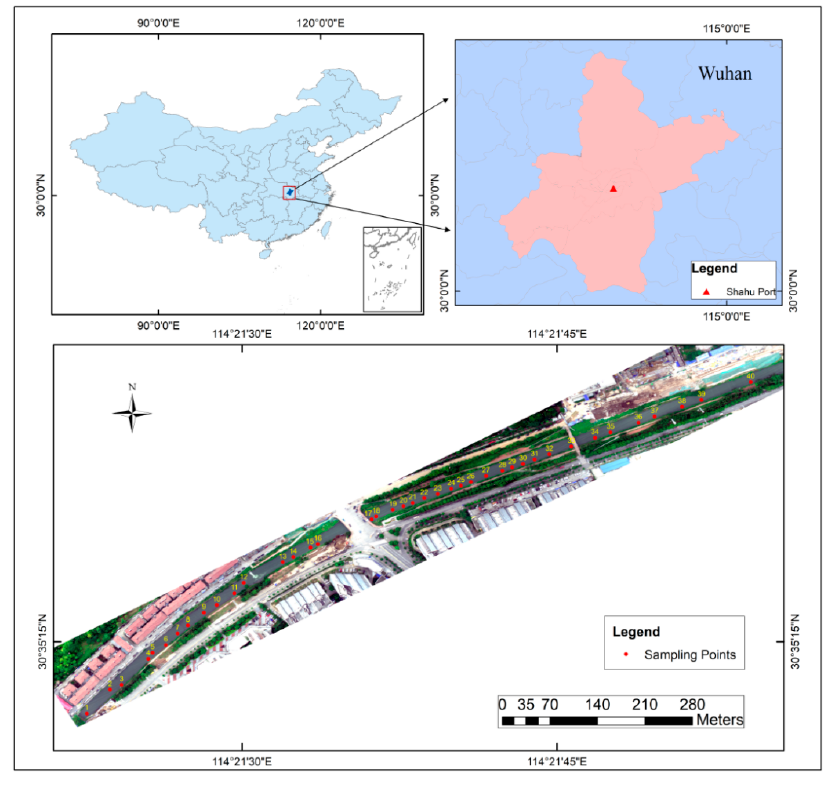
Figure 1. Sampling stations in Shahu Port.